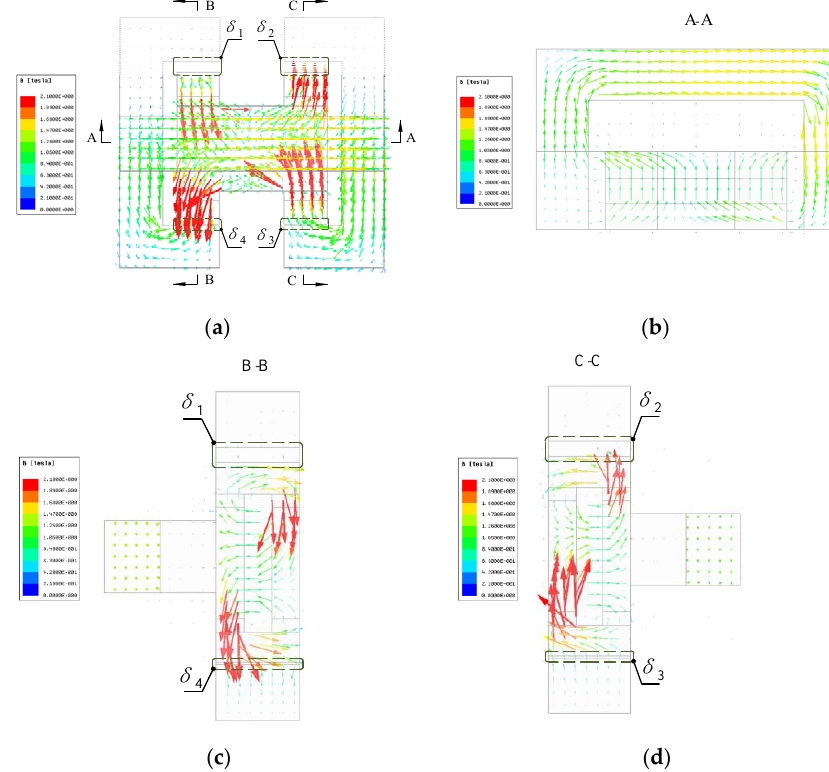
Figure 12. The magnetic field vector diagram of NLFM. ( a ) vertical view. ( b ) A-A section view. ( c ) B-B section view. ( d ) C-C section view.